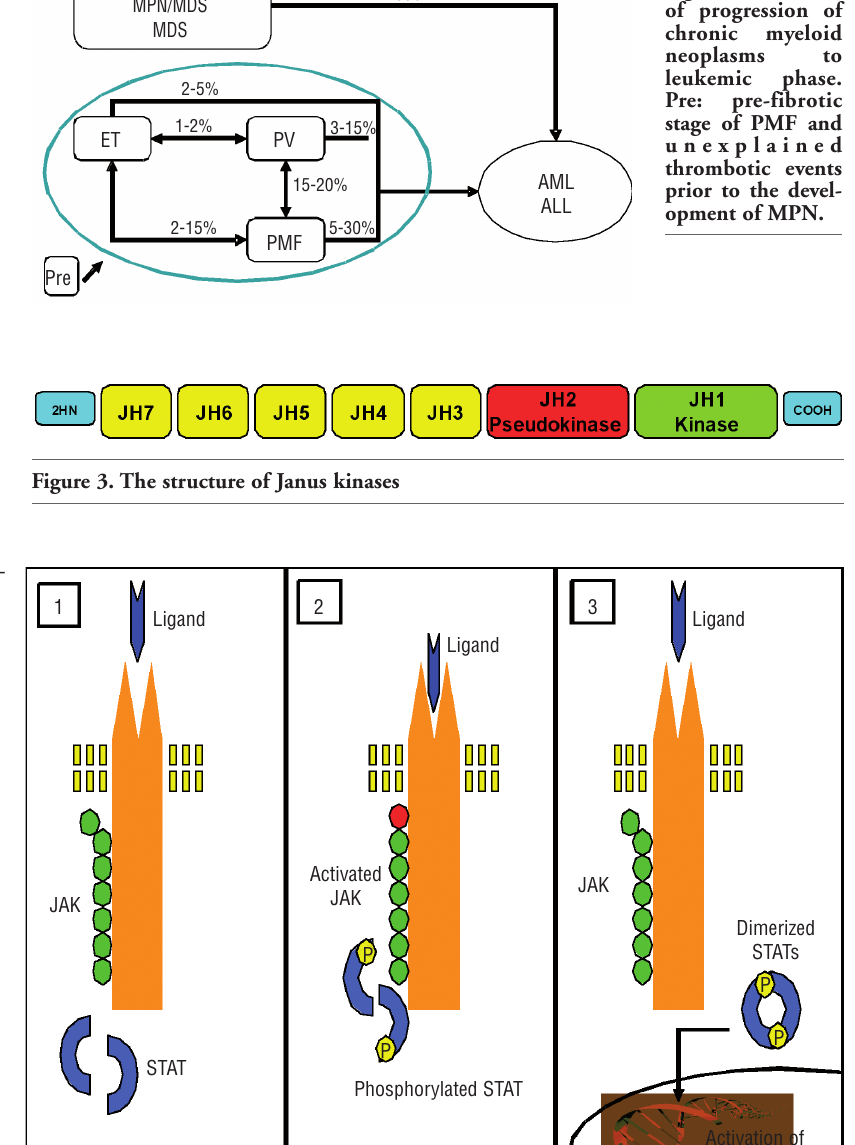
Figure 2. The rate of progression of chronic